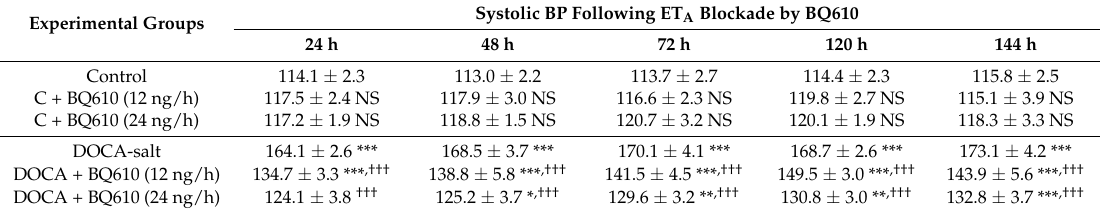
* p < 0.05, ** p < 0.01, and *** p < 0.001 vs. control; ††† p < 0.001 vs. DOCA-salt. Number of animals: control, 17; BQ610 (12 ng/h), 12; BQ610 (24 ng/h), 8; DOCA-salt, 17; DOCA-salt + BQ610 (12 ng/h), 11; and DOCA-salt + BQ610 (24 ng/h), 10. NS: Not significant. Table 2. Heart rate (HR) values following ET A blockade. HR is expressed as beats per minute (BPM) ± SEM. C, normotensive control; DOCA, DOCA-salt hypertensive rats. Number of animals: control, 17; BQ610 (12 ng/h), 12; BQ610 (24 ng/h), 8; DOCA-salt, 17; DOCA-salt + BQ610 (12 ng/h), 11; and DOCA-salt + BQ610 (24 ng/h),